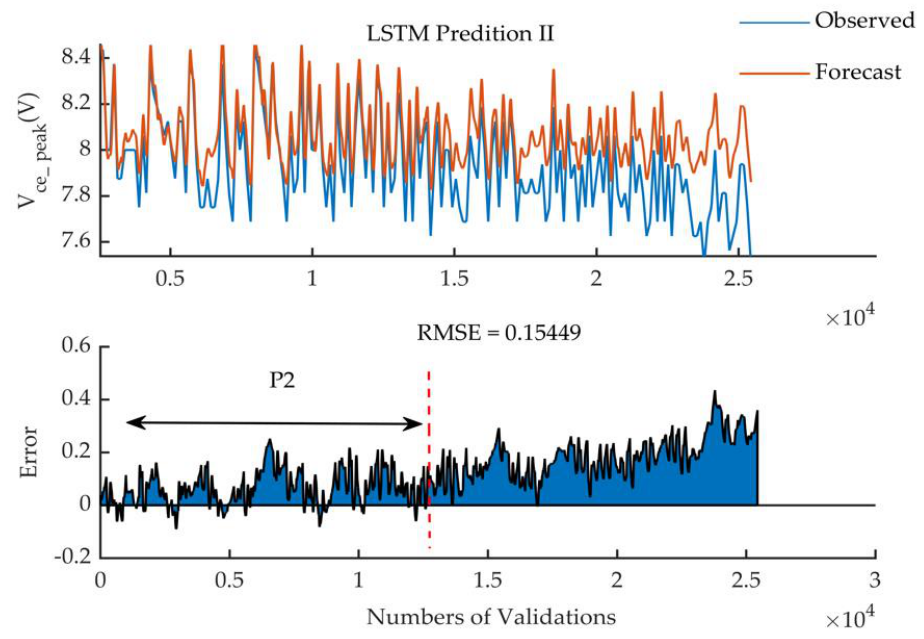
Figure 6. The second LSTM prediction.